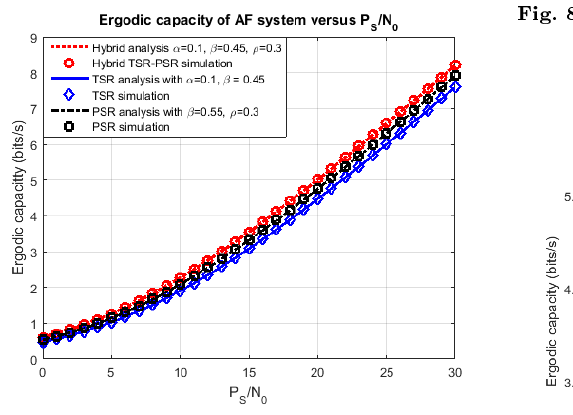
Fig. 7: Ergodic capacity versus P S /N 0 for 3 protocols.